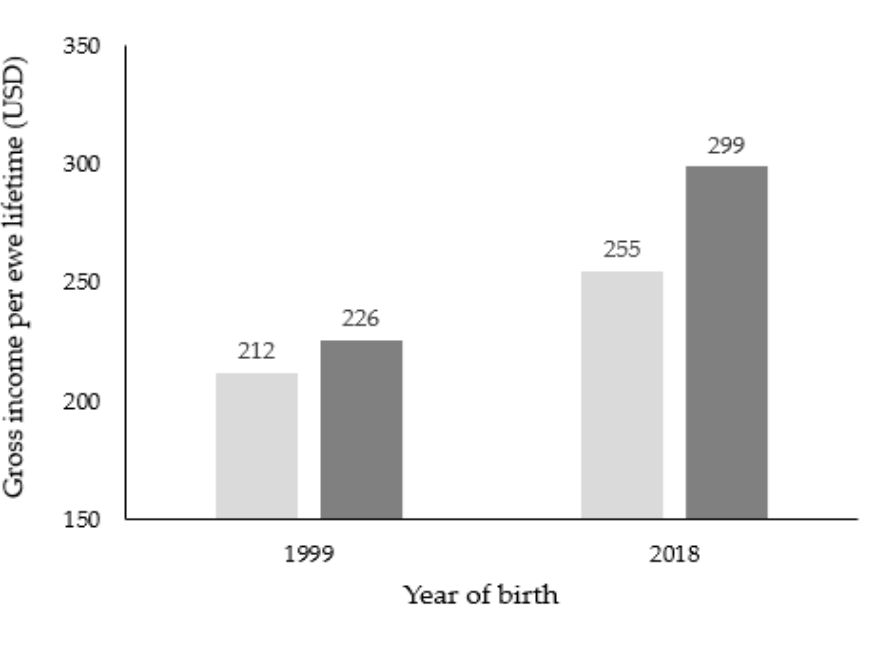
Figure 7. Gross income per ewe lifetime (across four lambing opportunities) per year of birth (1999– 2018) in the nucleus flock. Total wool production and total lamb live weight at weaning across four lambing opportunities were assumed constant across years. It was assumed that all lambs were sold at weaning. Average wool and meat prices were calculated for the period 2013–2019 [3,35] and uti- lized for the entire analysis period (1999–2018).